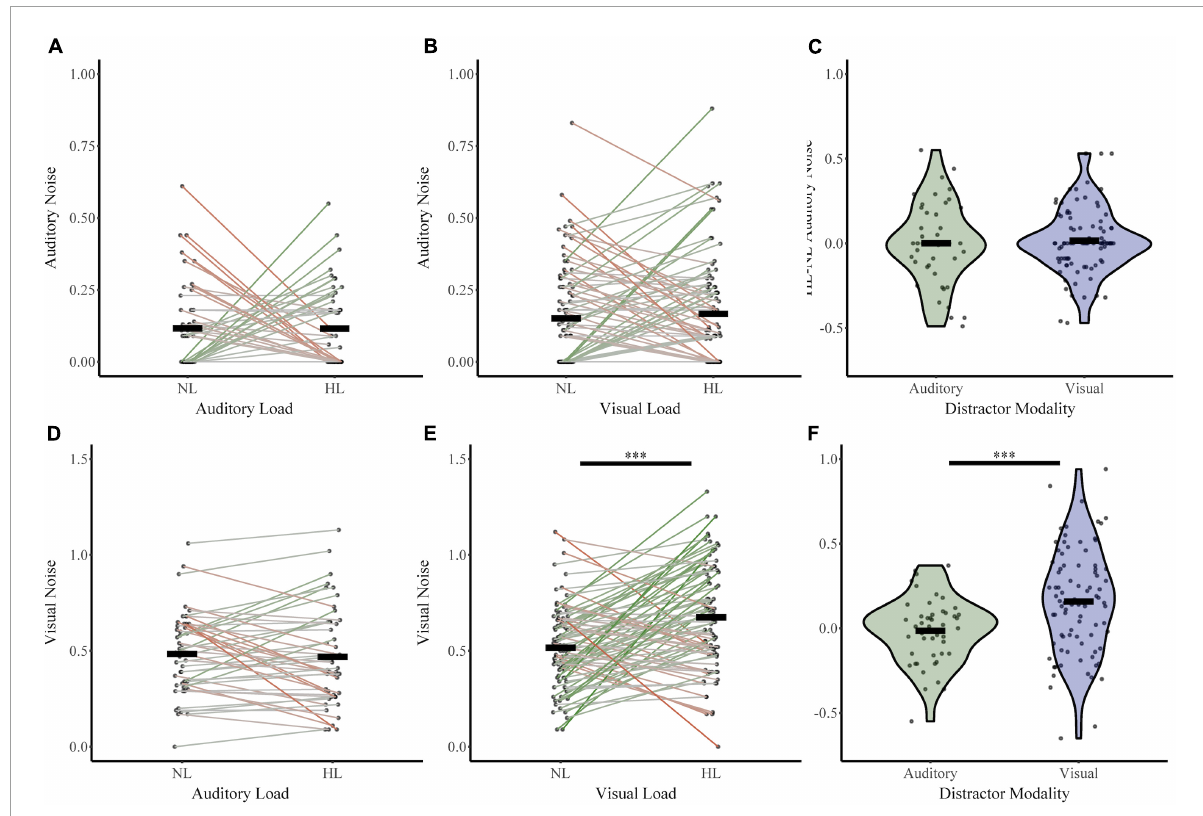
FIGURE5 Changes in sensory noise across perceptual load. Auditory noise does not change with increasing auditory (A) or visual (B) perceptual load. Visual noise increases with increasing visual (E) but not auditory (D) noise. HL-NL differences in auditory noise (C) and visual noise (F) confirm that visual load selectively increases visual noise. Horizontal black bars indicate group averages, and violin plots display the distribution of HL-NL sensory noise differences for each distractor and noise modality. ∗∗∗ Indicates p < 0.001.